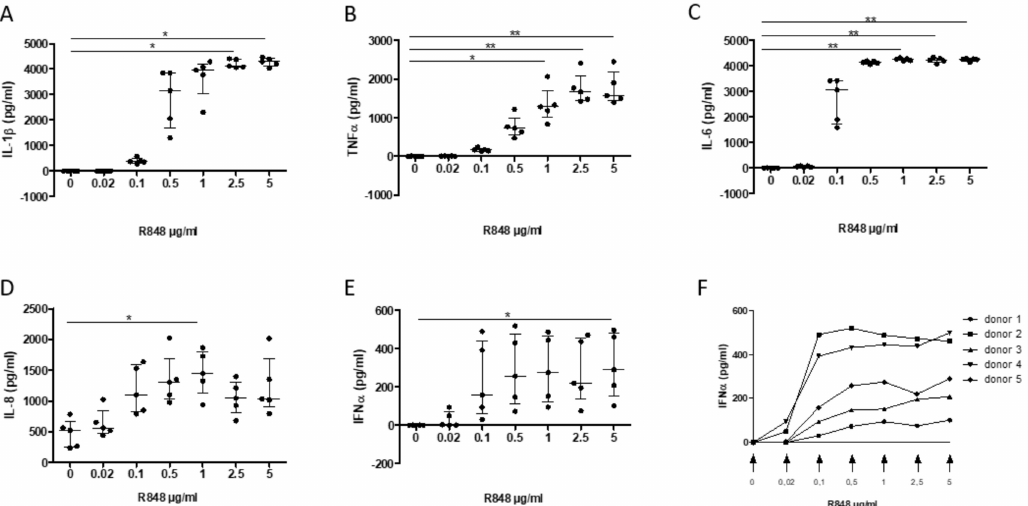
Figure 3. Dose-response release of interleukin (IL)-1 β ( A ), TNF- α ( B ), IL-6 ( C ), IL-8 ( D ), and IFN- α ( E – F ) following PMBC activation by R848 (0.02, 0.1, 0.5, 1, 2.5, and 5 µ g/mL; 0, DMSO control) on PMBC release of interleukin (IL)-1 β ( A ), TNF- α ( B ), IL-6 ( C ), IL-8 ( D ), and IFN- α ( E , F ). Data are median ± interquartile range ( n = 5 separate experiments; * p < 0.05, ** p < 0.01).